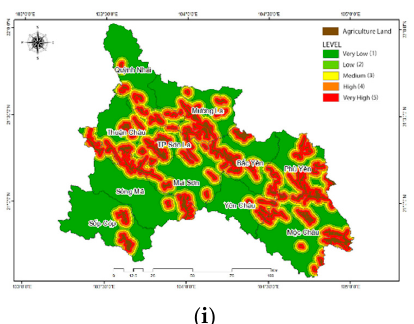
Figure 6. Evaluative layers for establishing a forest fire risk map in Son La Province: ( a ) slope; ( b ) elevation; ( c ) slope direction; ( d ) forest cover; ( e ) distance to roads; ( f ) distance to residential areas; ( g ) humidity; ( h ) distance to rivers; and ( i ) distance to fields.